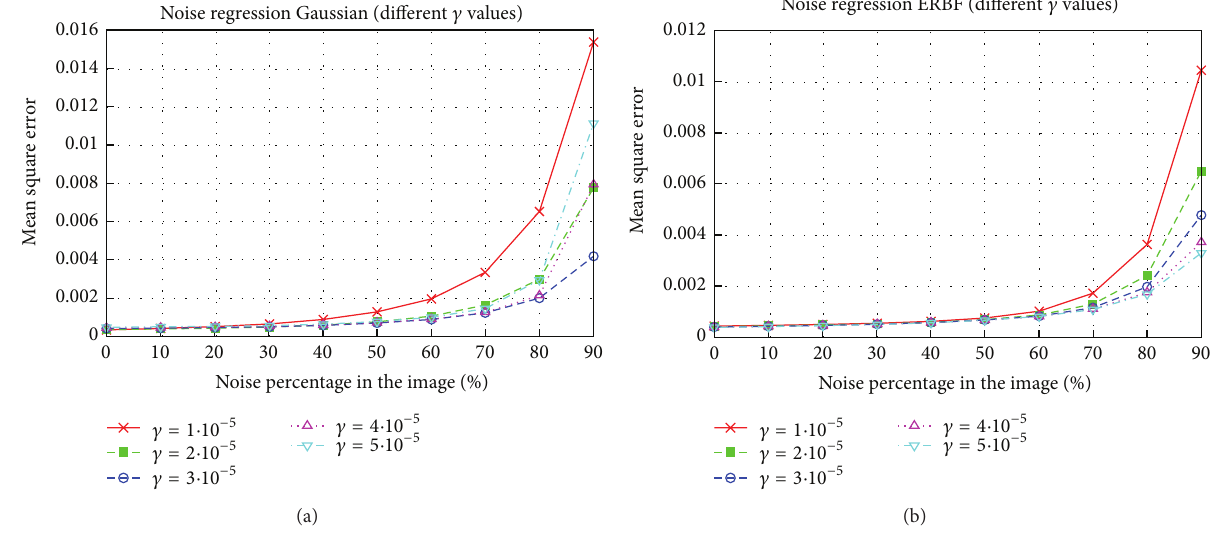
Figure 8: Mean square error for different values of 𝛾 in Gaussian and ERBF kernels.